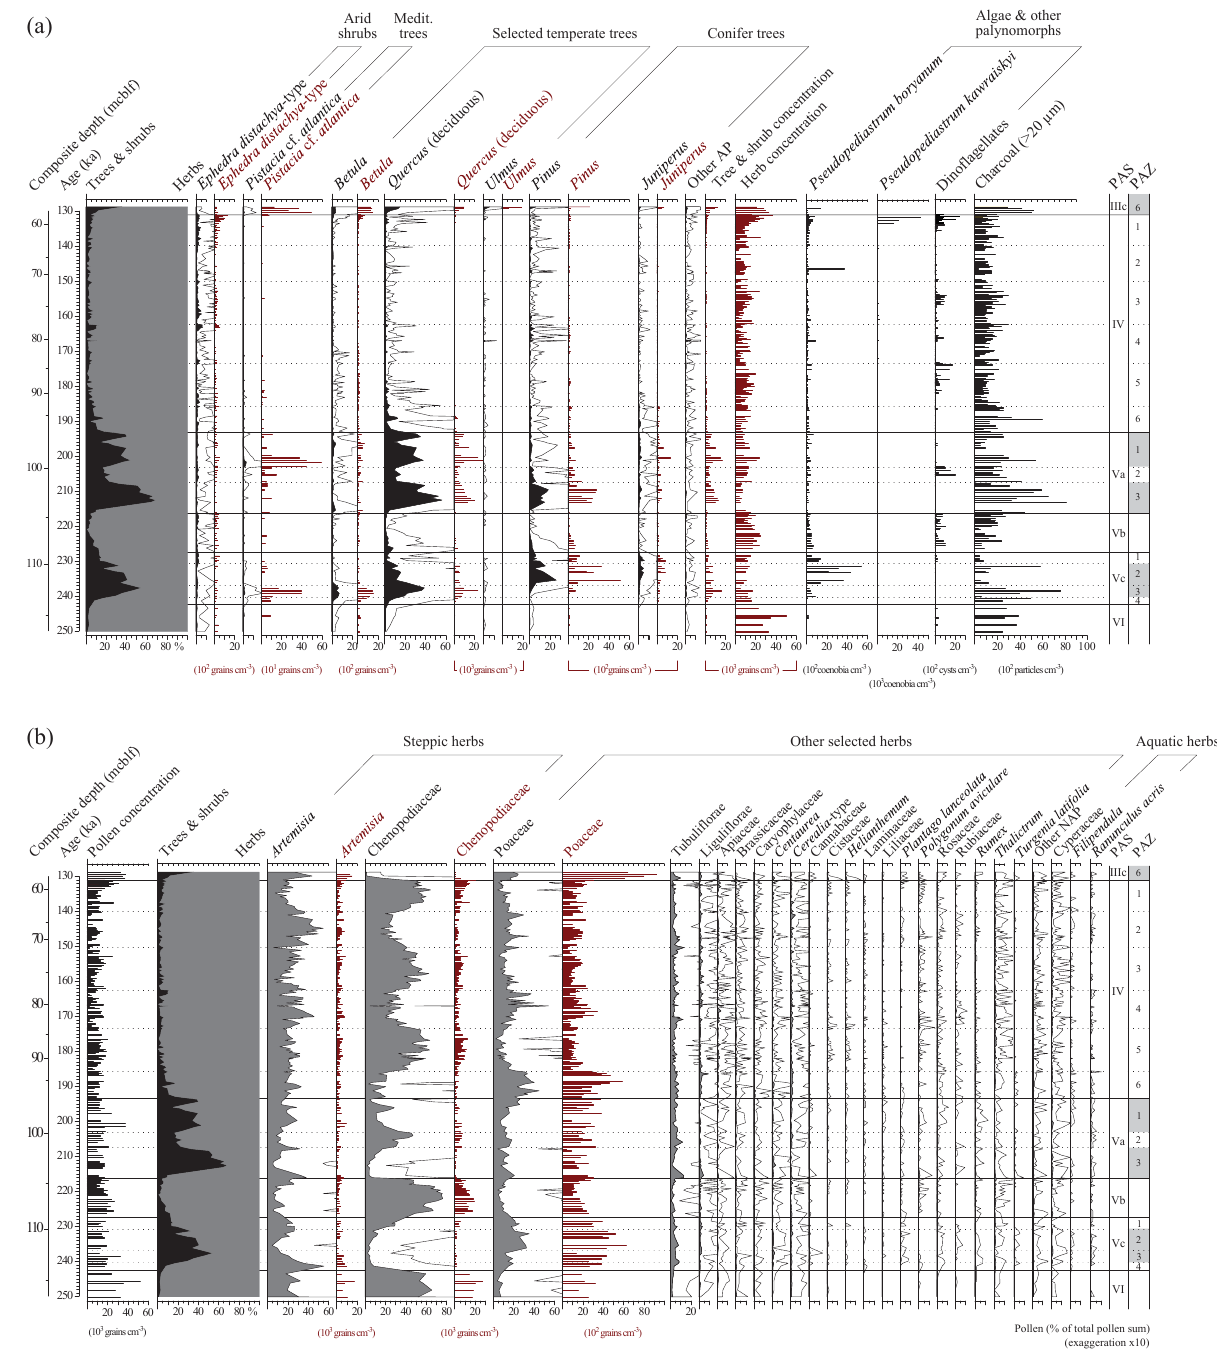
Figure 2. Pollen diagram inferred from Lake Van sediments plotted against composite depth (mcblf) and age (ka). (a) Selected arboreal pollen abundances are expressed as percentages and concentrations of the pollen sum (black curves), which excludes bryophytes, pteridophytes, and aquatic taxa. Rare taxa are summed and presented as “other AP”. Selected arboreal pollen concentration (grains per cm 3 ; red bars) is also given. Concentrations of green algae ( Pseudopediastrum boryanum , P. kawraiskyi ; coenobia per cm 3 ; black bars), dinoflagellates (cysts per cm 3 ; black bars), and charcoal particles (>20µm, particles per cm 3 ; black bars) are presented. (b) Selected pollen percentages for non-arboreal taxa and key aquatic herbs (gray curves). Percentages and concentrations are calculated as for arboreal pollen. Rare taxa are summed as “other NAP”. Pollen assemblage superzones (PAS) and zones (PAZ; gray dashed lines) are indicated on the right and described in Table 2. Intervals characterized by oak steppe-forest (AP>30%) are marked in each diagram (gray box). An exaggeration of the pollen curves ( × 10; white curves) is used to show low variations in pollen